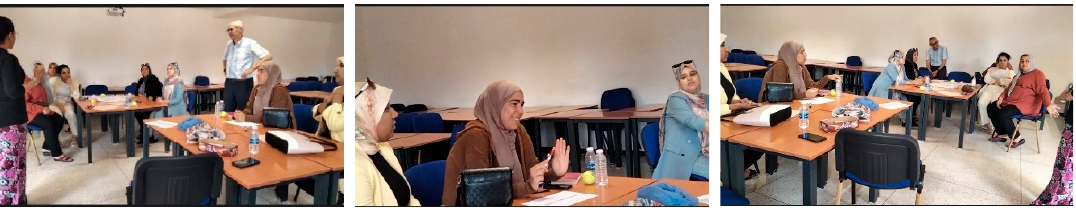
Figure 3. Pictures of the participants during the experiment.